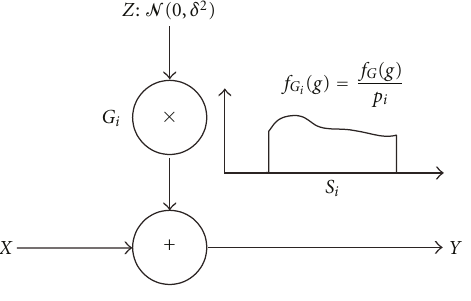
Figure 3: Channel model for a given q i .